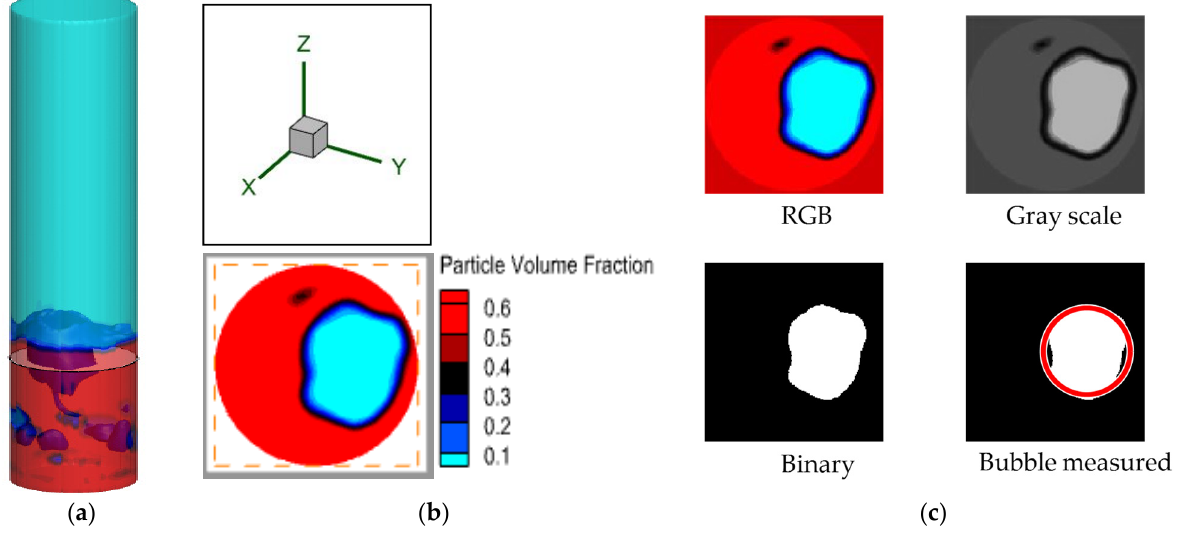
Figure 3 . ( a – c ) Bubble measured from the extracted images from XY-plane (horizontal plane) at a height of 25.8 cm and superficial gas velocity of 0.25 m/s (The red circle represents equivalent bubble area).